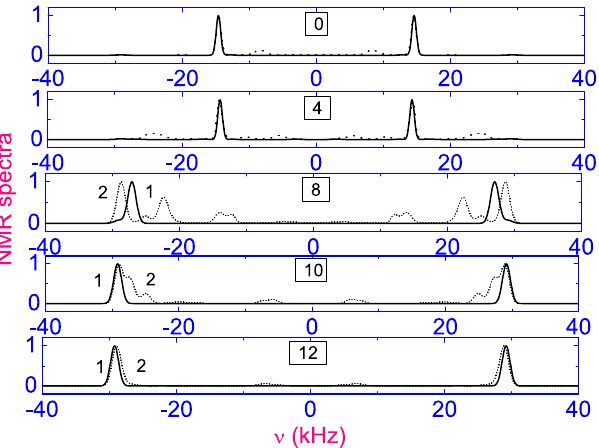
Figure 15. The deuterium NMR spectra I ( ν ) of 5CB-d 2 calculated (dotted curves) and measured (solid curves) for the turned-off process at 14.8 ◦